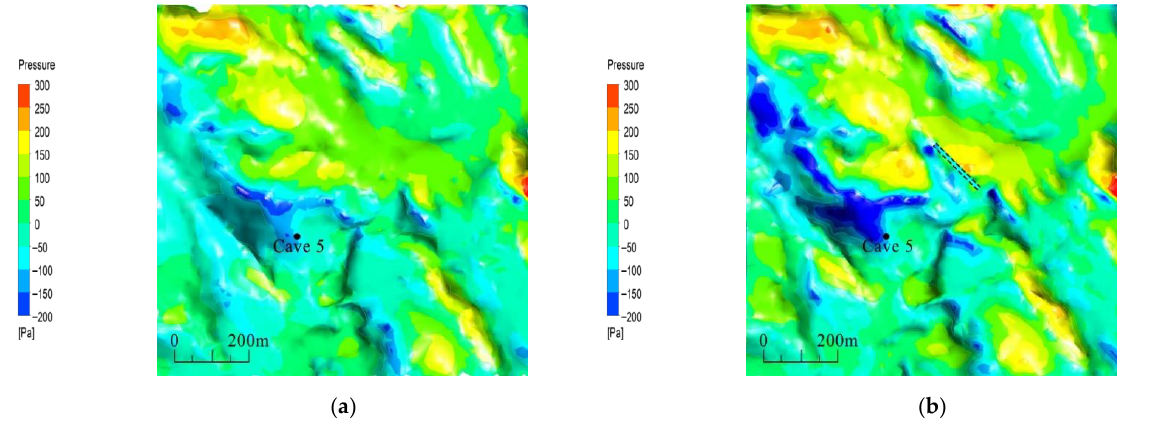
Figure 17. Contours of the simulated pressure around Cave 5 for the inlet wind directions of 45°, ( a ) without shelterbelt; ( b ) with shelterbelt. The rectangular in black line represents the position of shelterbelt.